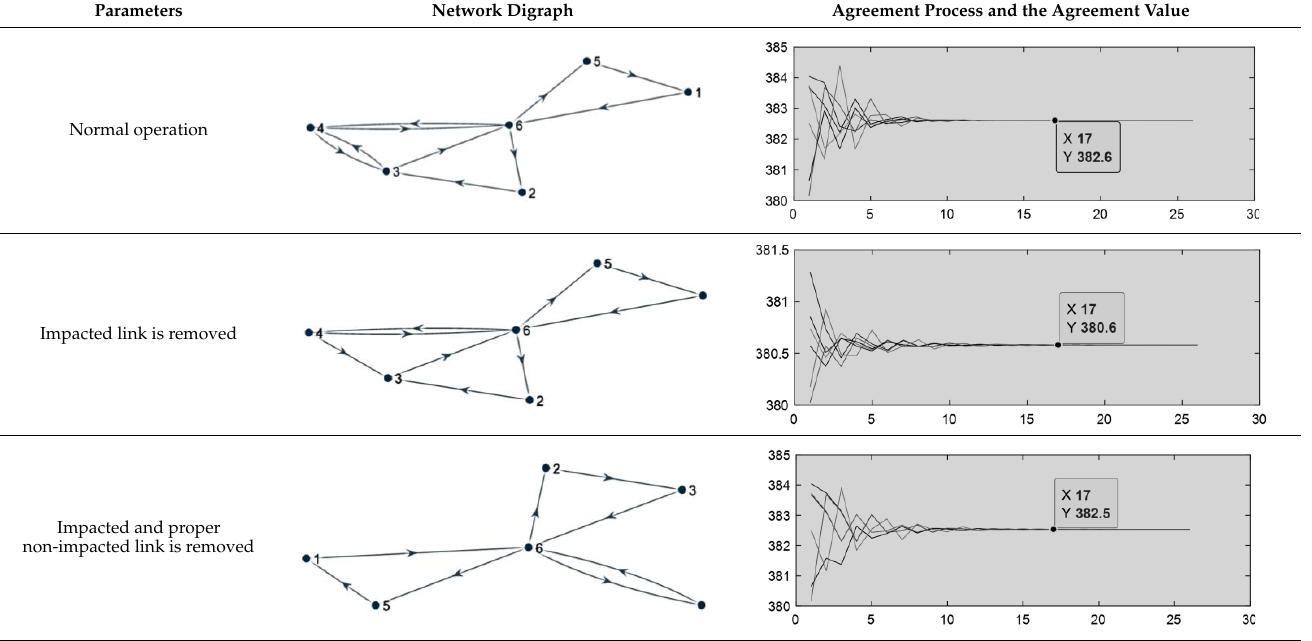
Table 3. Agreement Process and the Agreement Value under Different Operation Scenarios.